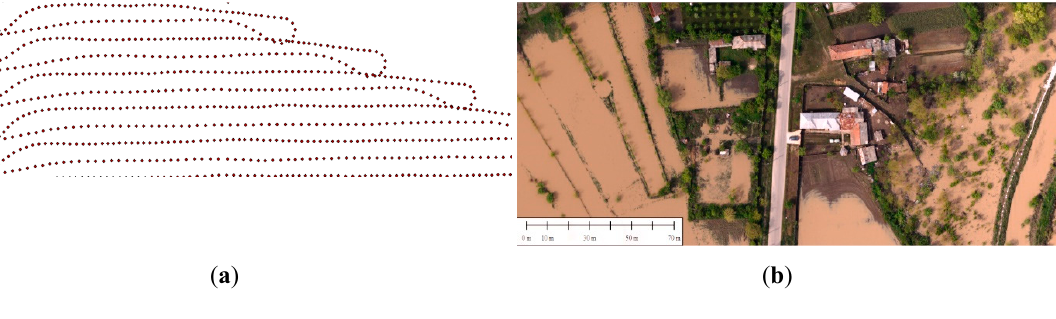
Figure 2. Image acquisitions: ( a ) the UAV trajectory—photogrammetry (cropped); ( b ) the orthophotoplan